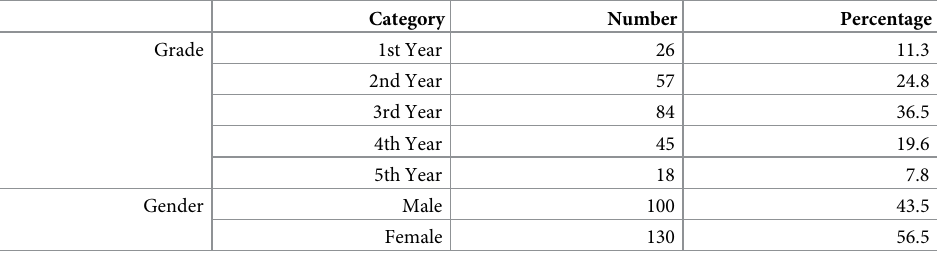
Table 1. Demographic attributes of the